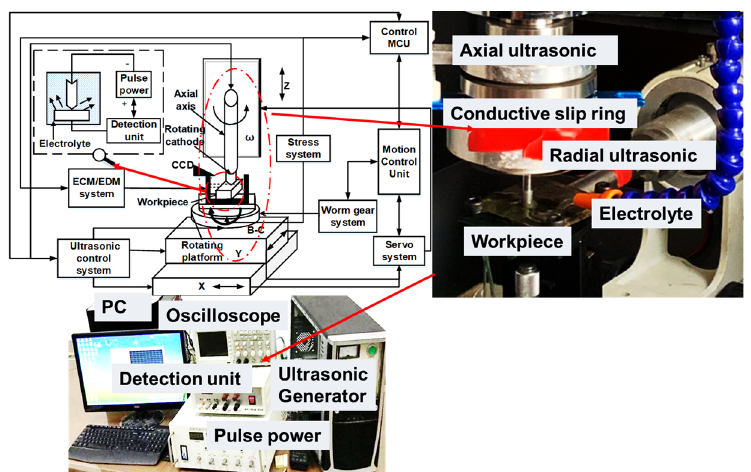
Figure 8. Overview of the Machining system.